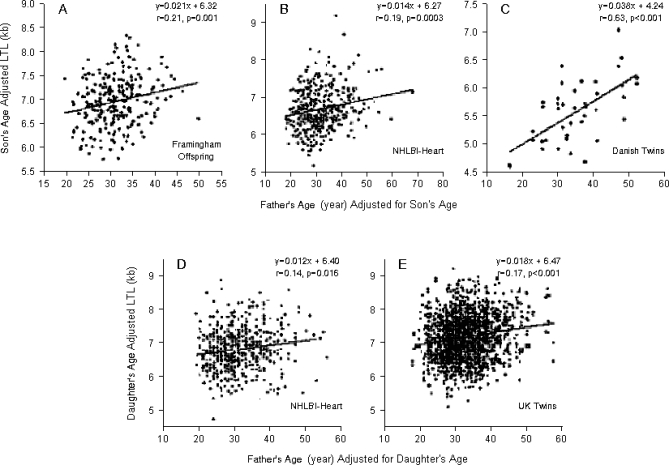
Offspring's Age-Adjusted LTL versus Father's Age at Birth of the Offspring, Adjusted for the Offspring's Age(A) Males (sons), Framingham Offspring; (B) Males (sons), NHLBI-Heart; (C) Males (sons), Danish Twins; (D) Females (daughters), NHLBI-Heart; (E) Females (daughters) UK Twins.